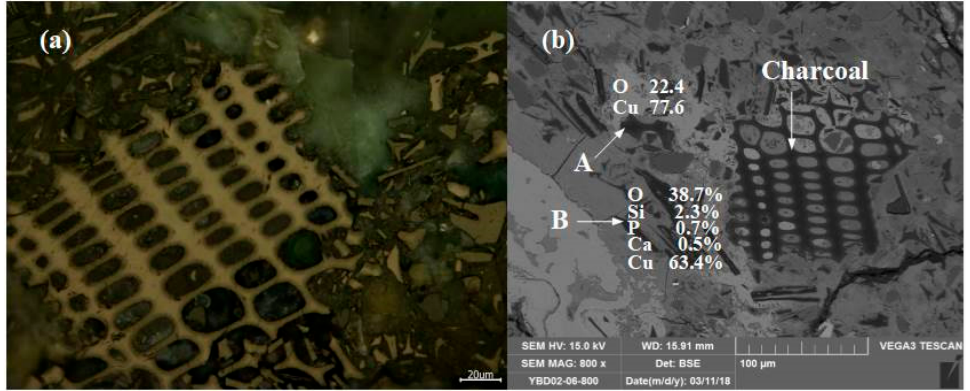
Figure 6. Optical micrograph ( a ) and SEM backscattered electron image ( b ) of YBD02. Sample YBD03: The EDS characterization result showed that Ca, P, and Fe were associated with the oxidized copper ore. The edge of Cu 5 FeS 4 (chalcopyrite) was wrapped by secondary Cu 2 S (chalcocite), and the two ores together formed inclusions that were distributed in the oxidized copper ore. As shown in Figure 7.